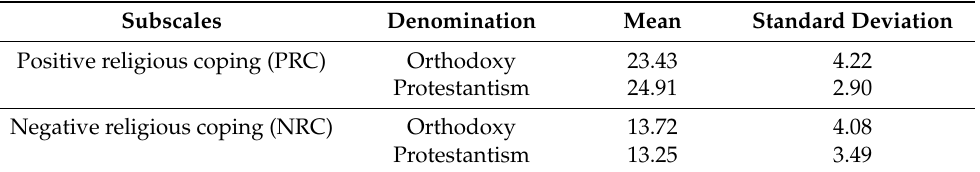
Table 8. Descriptive analysis of the Brief RCOPE